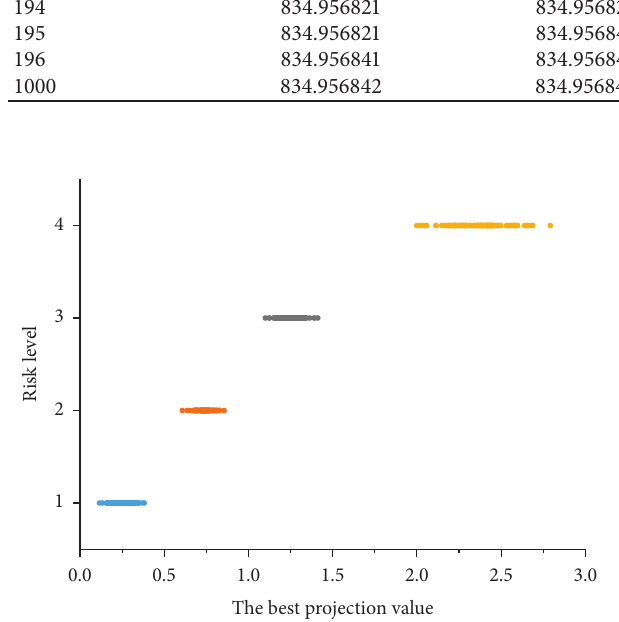
Figure 3: Scatter diagram of the standard evaluation object pro- jection values and risk